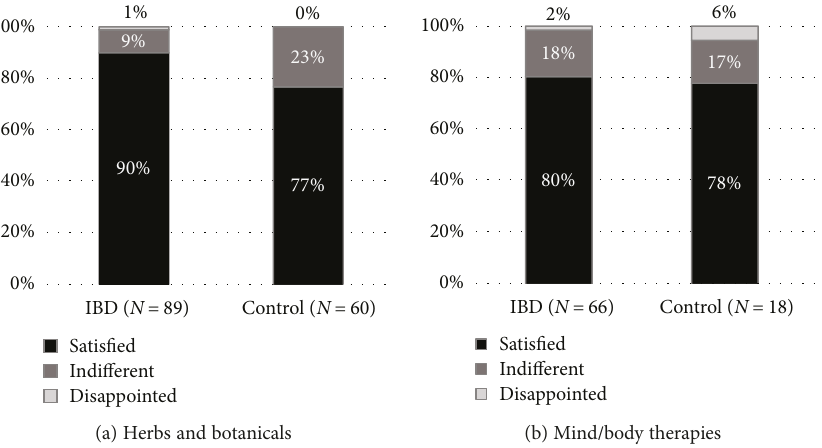
Figure 3: Patient opinions about herbs and botanicals (a) and mind/body therapies (b). IBD: in fl ammatory bowel